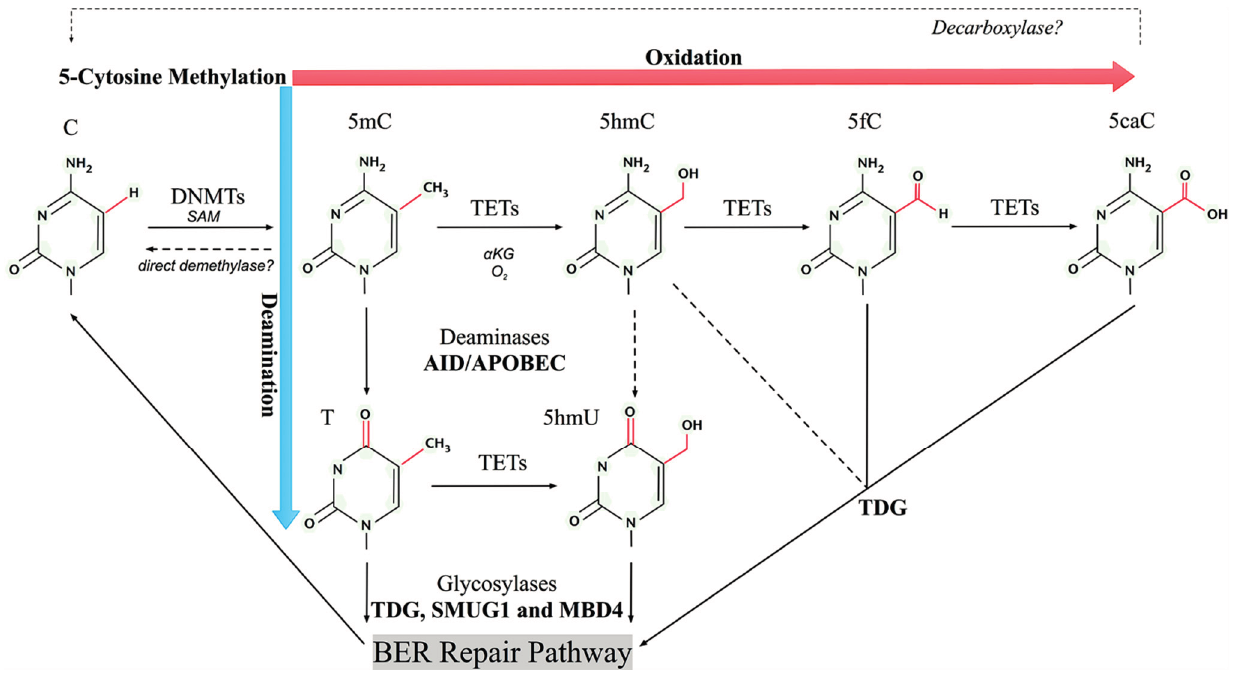
Figure 1. Model pathways of active DNA demethylation. DNA cytosine methyltransferases (DNMTs) with co-factor S -adenosyl methionine (SAM) establish and maintain 5-methylcytosine (5mC) from cytosine (C). A direct demethylase was hypothesised but has not been identified to date. The ten-eleven translocation (TET) family of dioxygenases can oxidize 5mC to generate 5-hydroxymethylcytosine (5hmC), 5-formylcytosine (5fC) and 5-carboxylcytosine (5caC). 5fC and 5caC can be removed by glycosylases such as